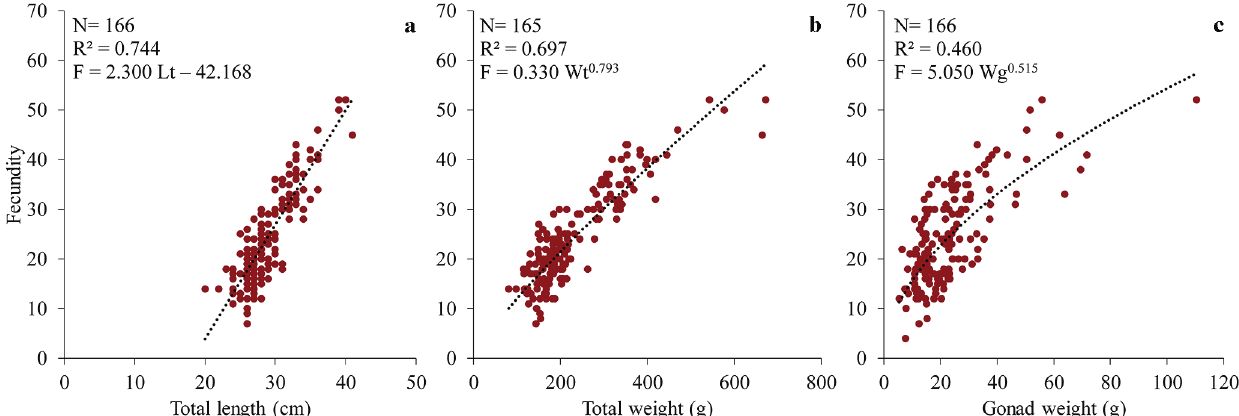
Fig. 9. Relationship between fecundity and a. total length, b. total weight and c. gonad weight of Genidens genidens females, in Guanabara Bay, Rio de Janeiro,